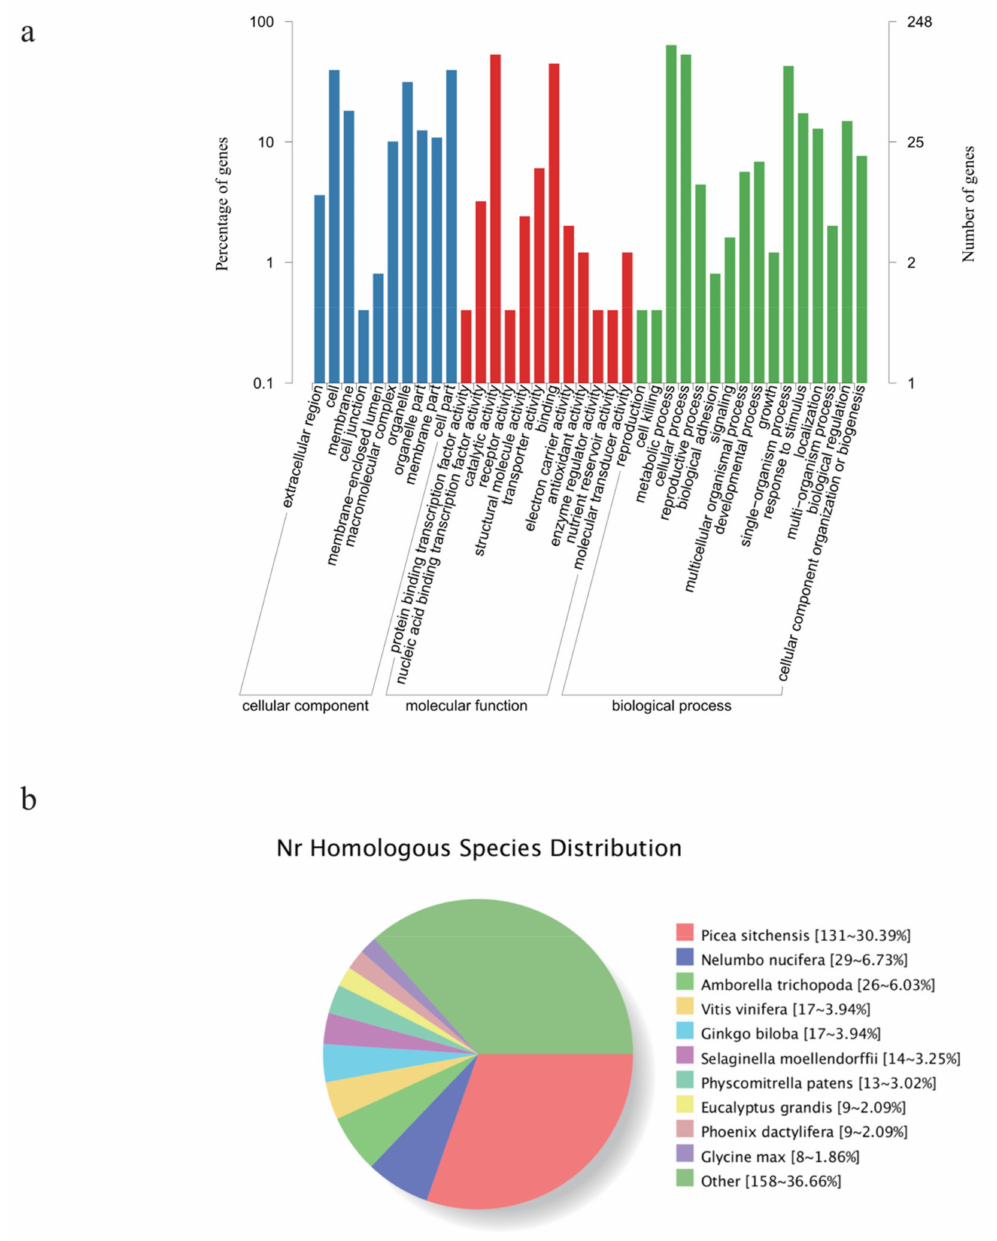
Figure 3. Annotation results of new genes. ( a ): Gene ontology (GO) annotation results of newly identified genes, including cellular component, molecular function, and biological process categories. ( b ): Homology comparisons between G. biloba new genes and the existing gene sets in multispecies. These new genes are mostly homologous with the existing genes of Picea sitchensis